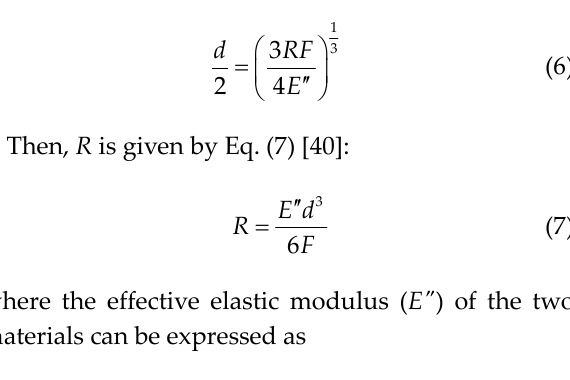
Fig. 5. When the steel surface is treated by PEG(aq), BL can occur between the solid asperity contact region during the initial period (Fig. 5(a)). The asperities